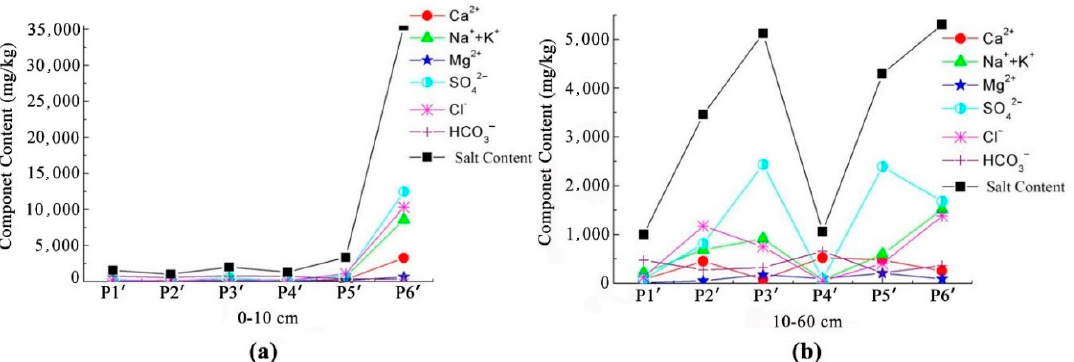
Figure 10. Component content of soil profiles: ( a ) 0–10 cm and ( b ) 10–60 cm.